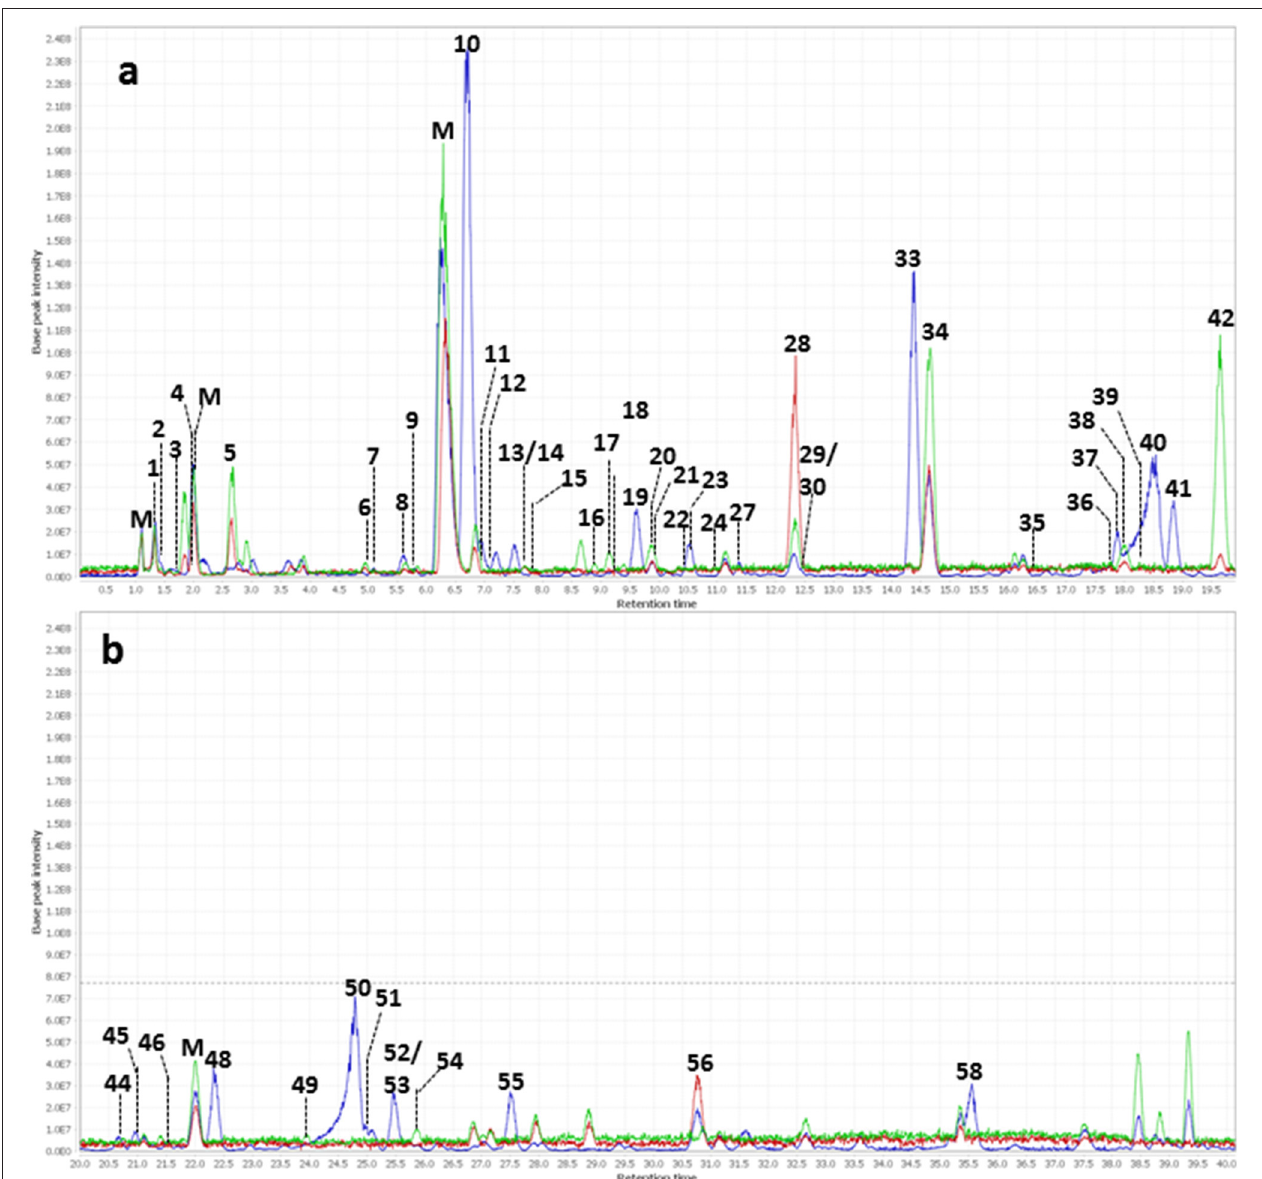
FIGURE 4 | Overlay of background subtracted base peak chromatograms (m/z 100–1500) of WBE (2 mg/ml) in HFS (0.1 g/ml in PBS buffer) at t 0 (blue) t 4 (red) and t 24 (green). (a) Chromatogram at retention time 0–20min; (b) chromatogram at retention time 20–40min. Peak numbers are as indicated in Table 3 . M, matrix peaks (peaks that are also contained in HFS samples without WBE